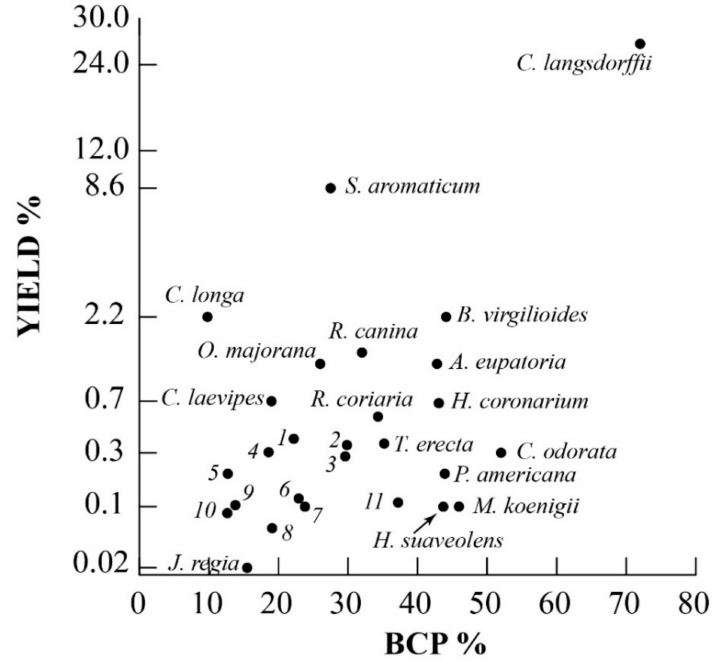
Figure 5. Scatter plot of BCP% and yield% of plant species present in the Belfrit list. The yield axis is scaled as a power of 0.2 in order to evidence species with yields ranging from 0.02 to 8.6%. 1, Pinus pinaster Aiton; 2, Ocimum tenuiflorum L.; 3, Aegle marmelos (L.) Corr.; 4, Protium heptaphyllum (Aubl.) March.; 5, Artemisia verlotiorum Lam rinus o ffi cinalis L.; 6, Annona squamosa L.; 7, Cannabis sativa L.; 8, Centella asiatica L.; 9, Annona muricata L.; 10, Rosmarinus o ffi cinalis L; 11, Perilla frutescens var. japonica (Hassk.) H.